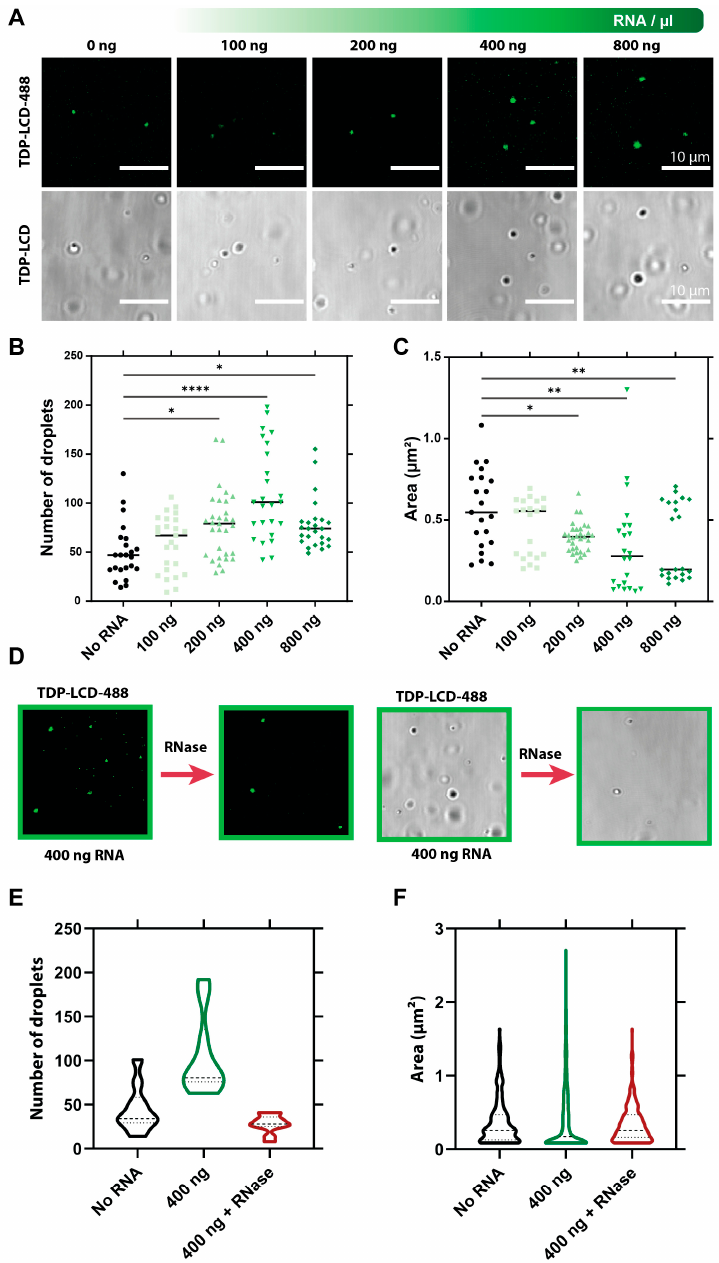
Figure 5. Use of RNA on TDP-43 LCD liquid–liquid phase separation. ( A ) Visualization of TDP-43 LCD droplets in LLPS+ buffer (phosphate buffer, 50 mM, pH 7.5) after a 10-min incubation with different concentrations of yeast RNA. Images taken with differential interference contrast (DIC) microscopy and fluorescence microscopy using the same fields of view, all conditions spiked in with labeled TDP-43-LCD 488 protein to visualize fluorescence. ( B ) Quantification of the number of droplets of labeled TDP-43 LCD in the absence and presence of increasing concentrations of yeast RNA in the LLPS+ buffer. ( C ) Quantification of the droplet area of labeled TDP-43 LCD. Automated analysis for ( B , C ) was performed for each condition. ( D ) Illustration of the effect of RNase treatment on labeled TDP-43 LCD droplet formed in the presence of yeast RNA (400 ng) after treatment with RNase (5 ng/ µ L). At the left side the fluorescent image is shown, while the same areas using DIC are presented on the right. ( E ) Quantification of the number of labeled TDP-43 LCD droplets with and without RNase treatment. ( F ) Determination of the labeled droplet area of TDP-43 LCD in the different conditions. Statistical evaluations were performed using one-way ANOVA with Dunnett’s multiple comparisons test. Significance is indicated compared with the control (no RNA) * p ≤ 0.05, ** p ≤ 0.01, **** p ≤ 0.001; n = 3 with an n = 5–10 images per replicate; mean ± SD is